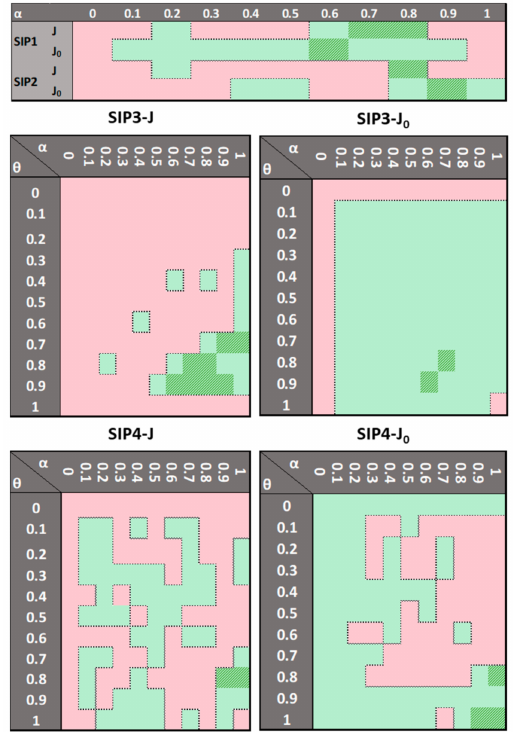
Figure 9. Convergence (green) and failure areas (red) in the s-parameter space for solving the case13659pegase. Bold green areas indicate where the studied technique successfully converged, employing the least number of